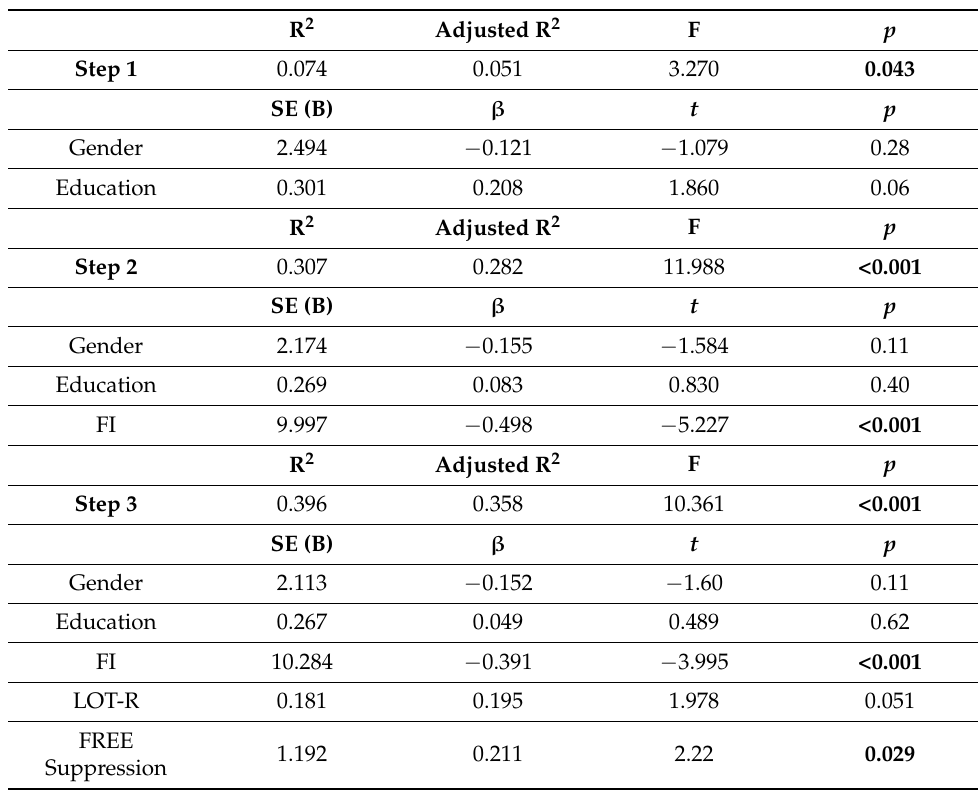
Table 4. Multivariate linear regression for PCS assessed at follow-up.